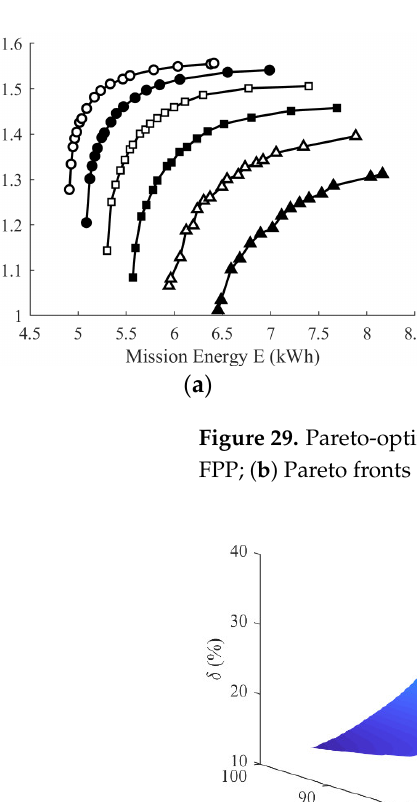
Figure 30. Energy-saving advantage of VPP over FPP with different  and  . ( a ) 3D surface diagram of  ,  and  ; ( b )   relation curves with different 